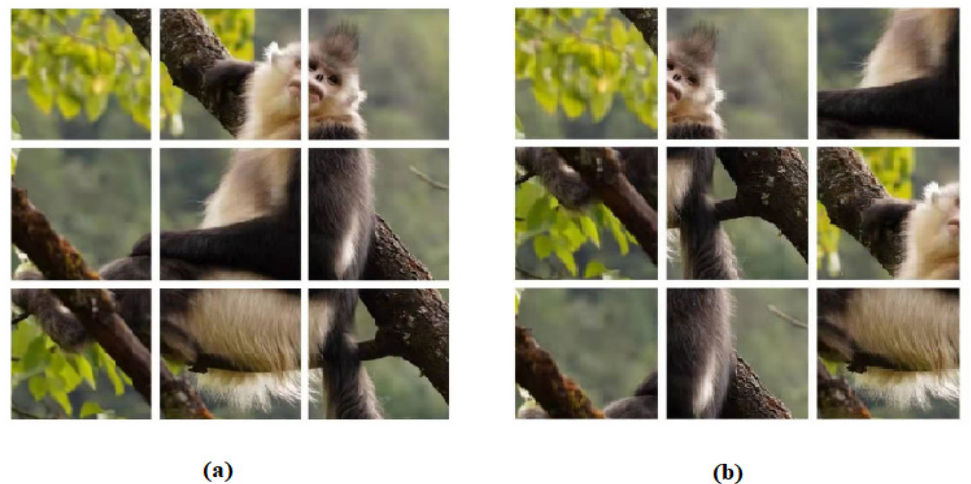
Figure 8. Different sequences in the same image. ( a ) is the sequence of images in normal order, and ( b ) is the sequence of images out of order.